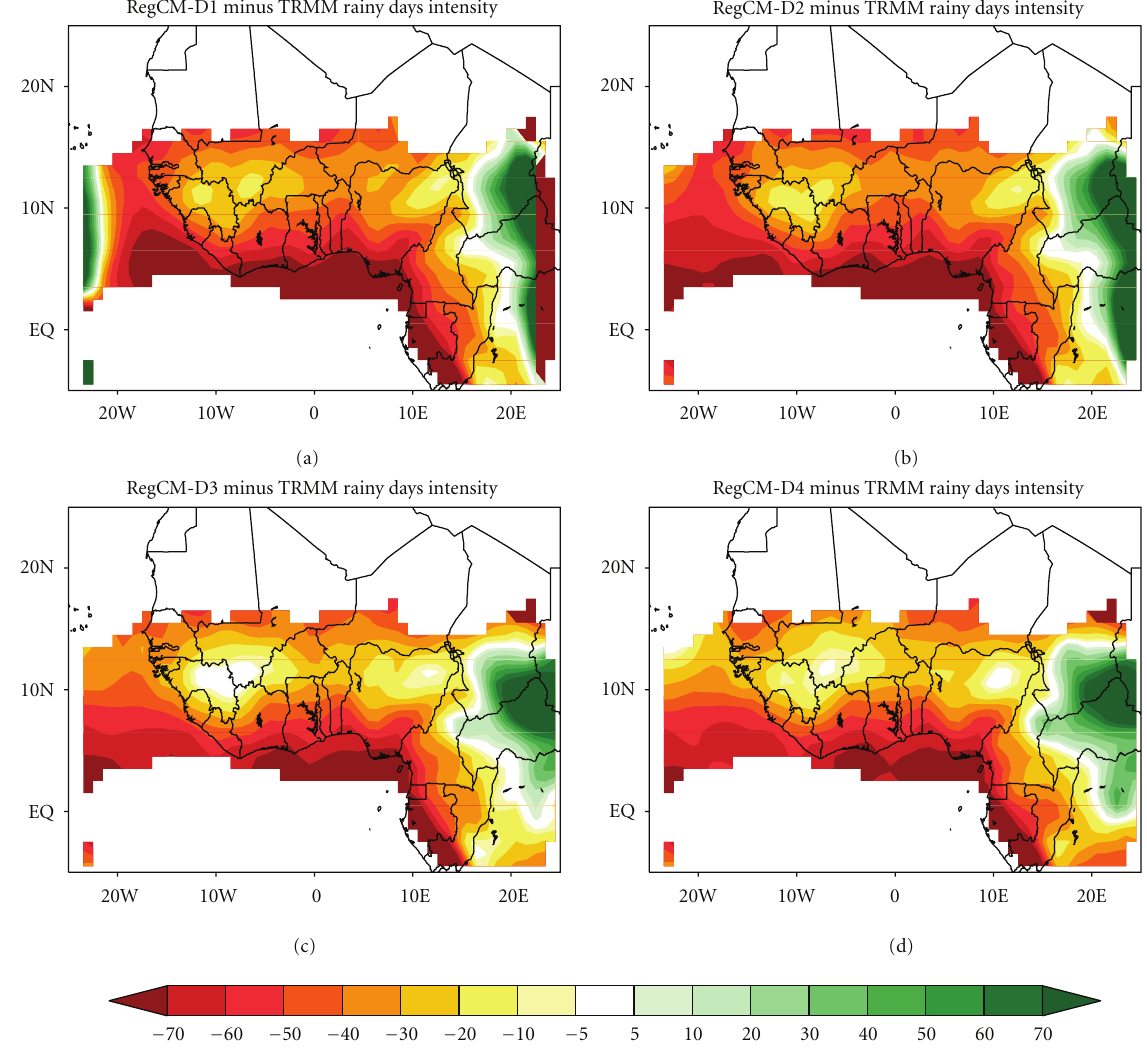
Figure 6: Di ff erences in mean intensity of rainfall events between (a) RegCM-D1 and TRMM, (b) RegCM-D2 and TRMM, (c) RegCM-D3 and TRMM, and (d) RegCM-D4 and TRMM. Units are expressed as percentage of TRMM values.